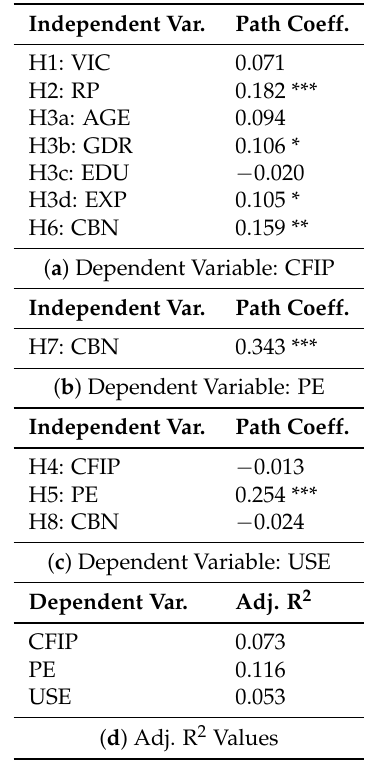
Table 1. Results of the structural model. Three, two and one asterisks show statistical significance at the 0.1%, 1% and 5% significance level, respectively (VIC: Prior privacy victim experiences, RP: Risk propensity, GDR: Gender, EDU: Education, EXP: Smartphone experience, CBN: Childhood